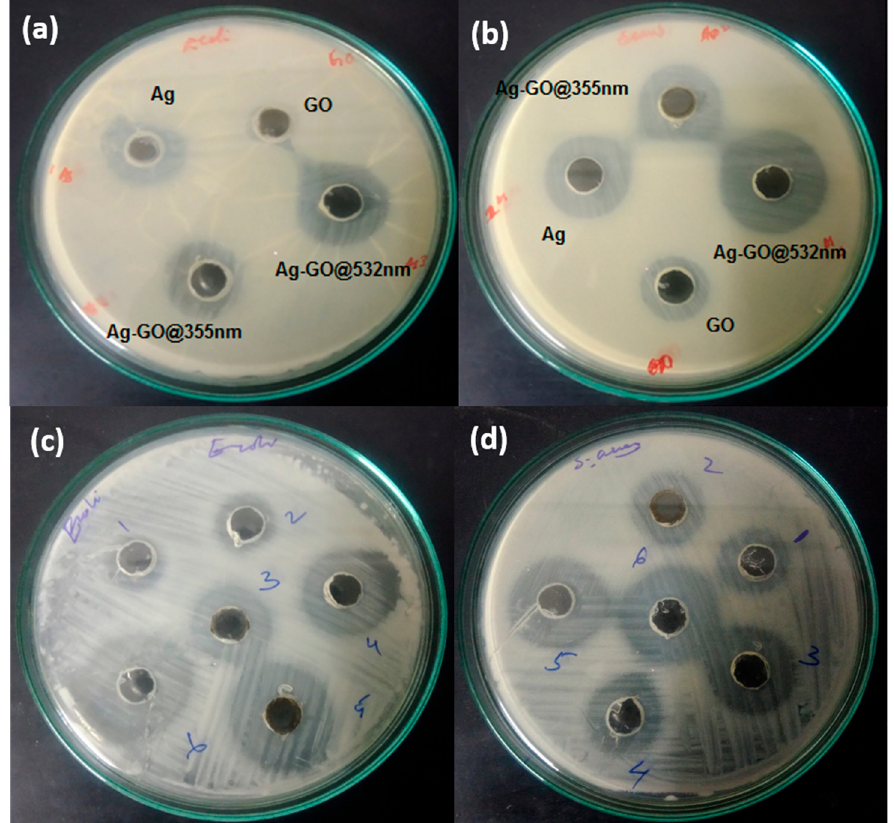
Figure 5. Inhibition zone images of ( a ) E. coli for GO, silver nanoparticles (Ag NPs), Ag-GO@355 nm and Ag-GO@532 nm, ( b ) S. aureus for GO, Ag NPs, Ag-GO@355 nm and Ag-GO@532 nm, ( c ) E. coli for Ag-GO@532 nm synthesized at five different ablation times, and ( d ) S. aureus for Ag-GO@532 nm synthesized at five different ablation times.